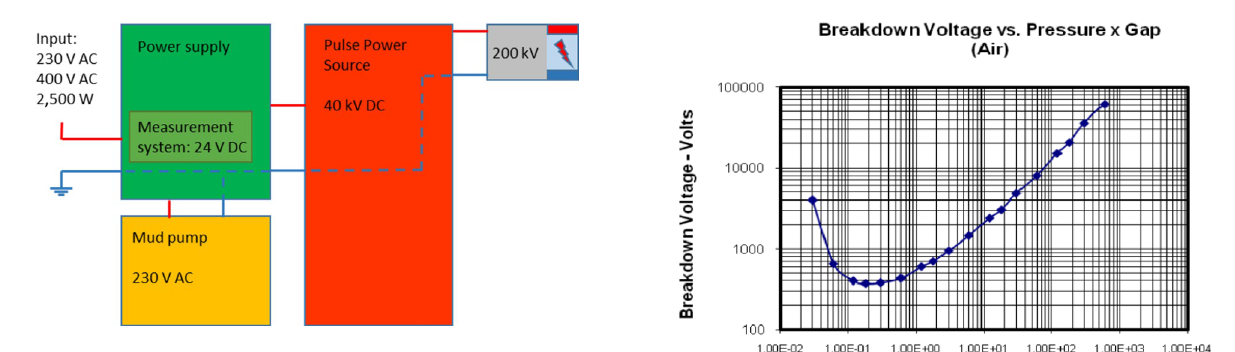
Fig. 14 Voltage levels and supply of the system